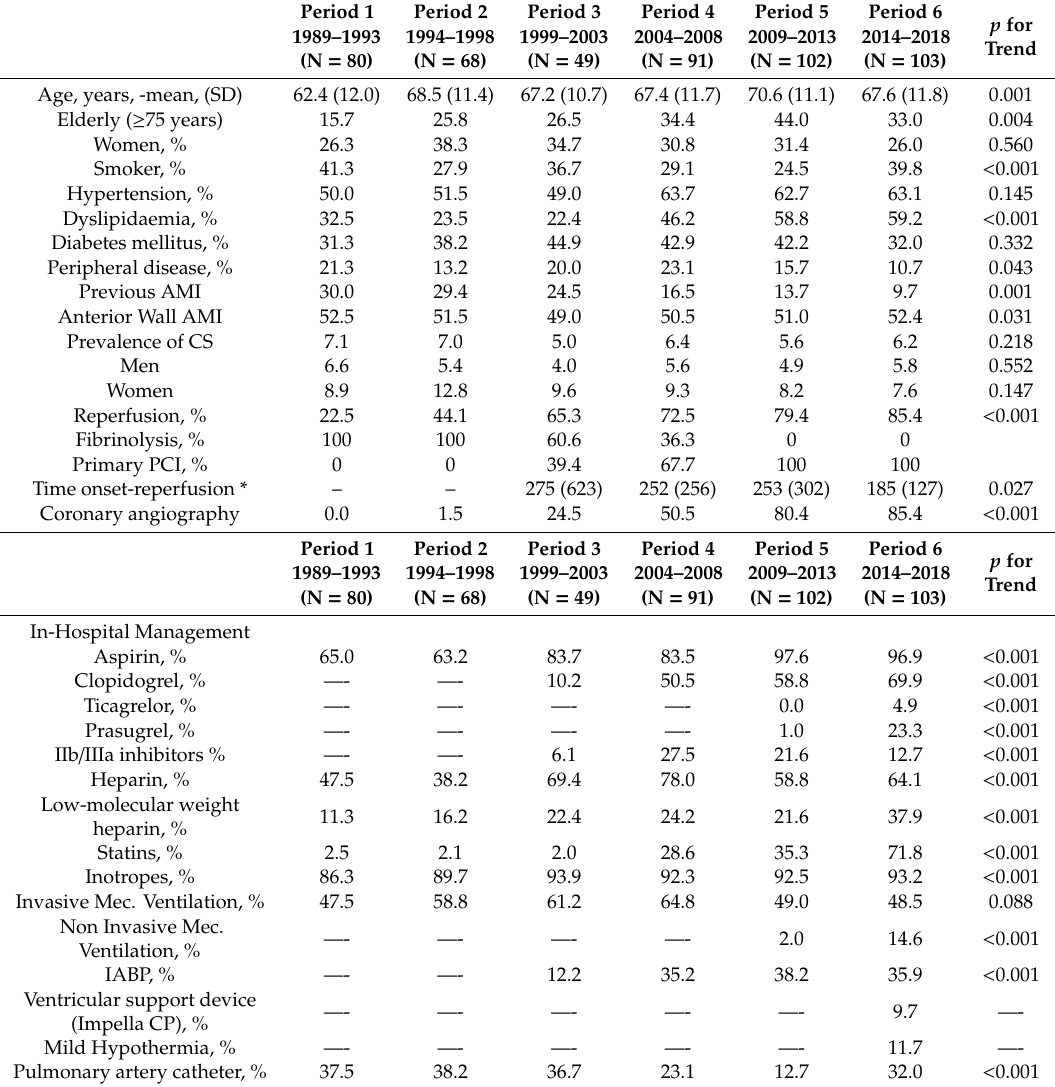
Table 2. Demographic characteristics and management of STEMI-CS patients across the six studied